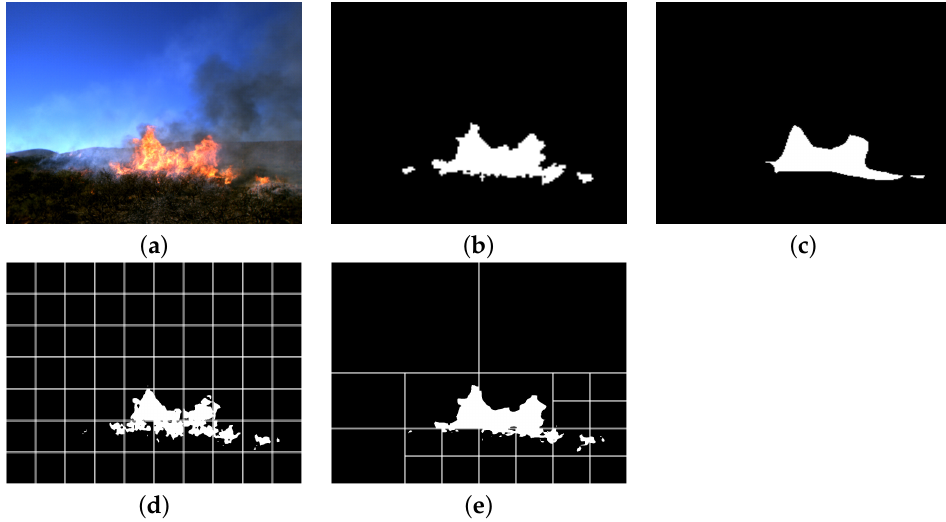
Figure 4. Comparison of the segmented masks produced by different methods and visualization of the searches. The searched regions are indicated by white borders. ( a ) Input Image, ( b ) Ground-truth mask, ( c ) DeepLab v3 [12], ( d ) Exhaustive search (C + S), ( e ) Proposed quad-tree search (Q + C +